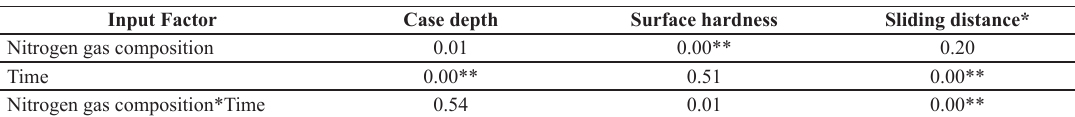
obtained through a two-way analysis of variance. Table 3. P -Value